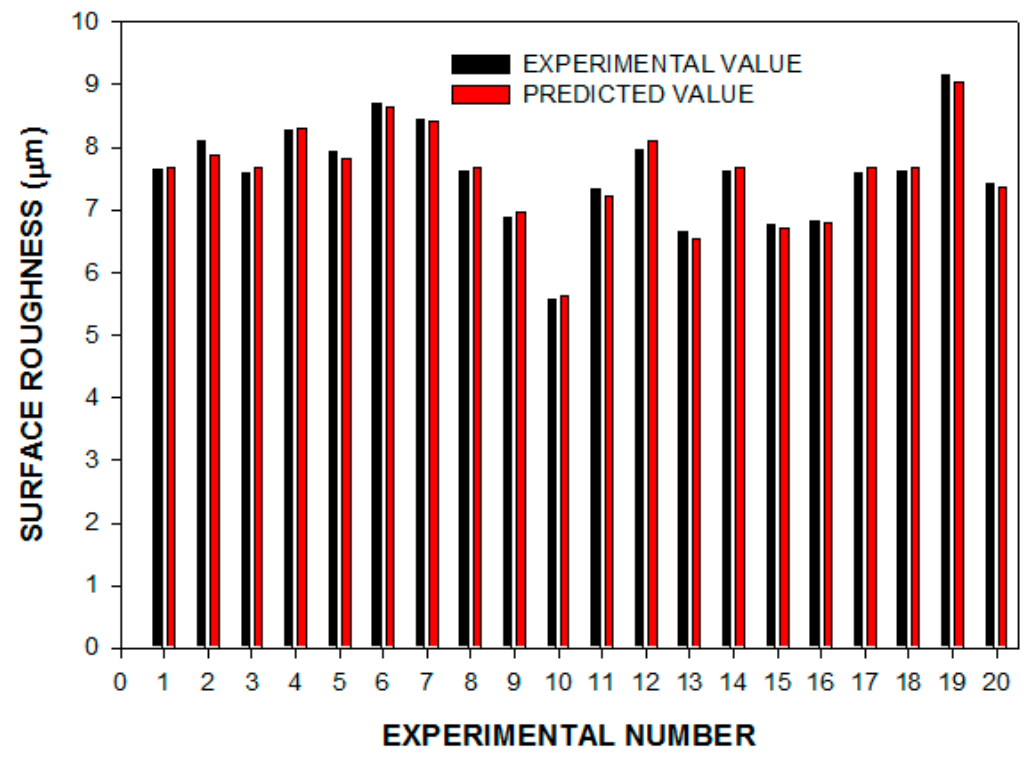
Figure 4. Experimental vs. predicted surface roughness. Table 8. Surface roughness model validation.